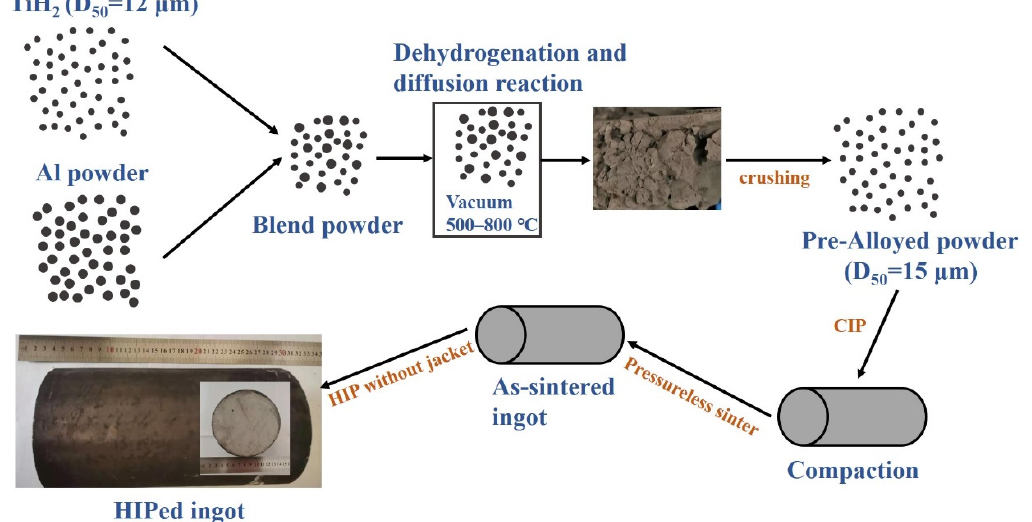
Figure 1. Schematic diagram for the preparation process of powder metallurgy (PM) TiAl alloy. HIP: hot isostatic pressing.